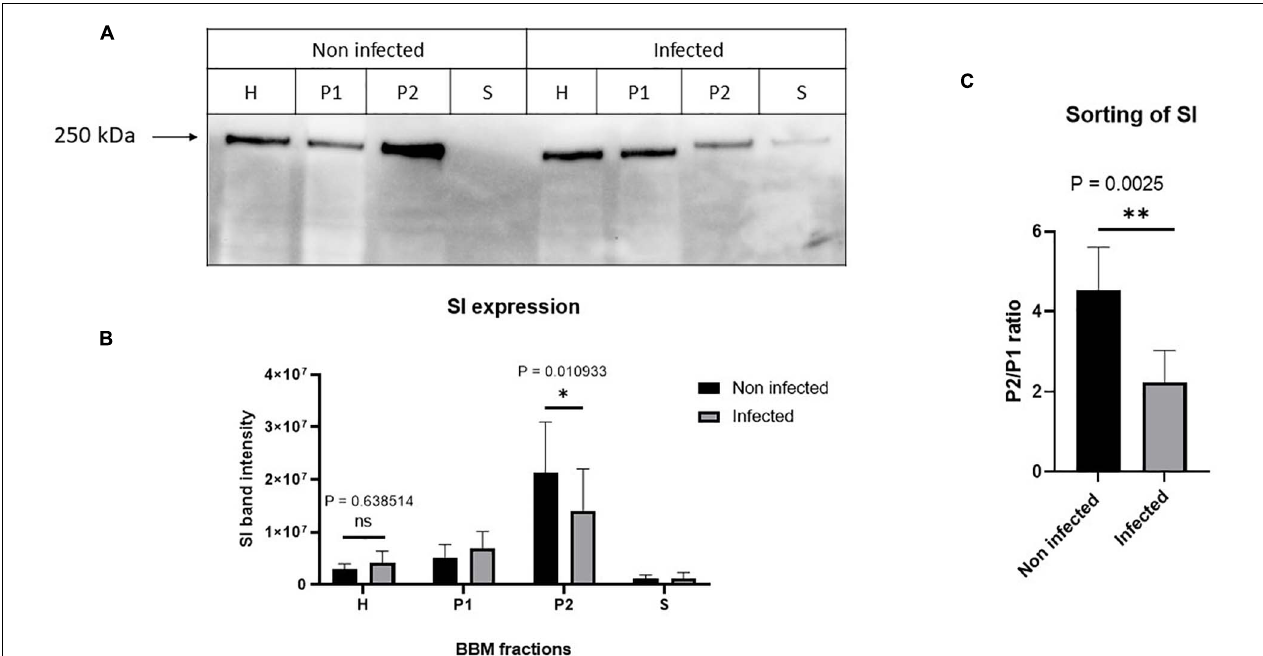
FIGURE 3 | Staphylococcus aureus Newman infection of Caco-2 cells induced impaired trafficking of sucrase–isomaltase (SI) to the brush border membrane (BBM). Caco-2 cells were infected or not infected with S. aureus Newman. Forty-eight hours post-infection, Caco-2 cellular homogenates (H) were partitioned into intracellular and basolateral membranes (P1), brush border membranes (BBM) (P2), and vesicular and soluble fraction (S). Equal protein amount from the different fraction was analyzed by Western blotting using monoclonal anti-SI antibody (A) . While the infection did not significantly affect the overall expression of SI, the trafficking to the BBM (P2) was significantly reduced (B) . The sorting efficiency of SI to the BBM after infection with S. aureus was analyzed via comparing the expression of SI in the P2 versus P1. The ratio P2/P1 showed that the sorting of SI to the apical membrane is significantly reduced after S. aureus infection (C) . ns, non-significant; and ∗ p ≤ 0.05 or ∗∗ p ≤ 0.01 using two-tailed Student’s t -test. Data represent mean ± SEM of three independent experiments with samples in duplicates or triplicates.